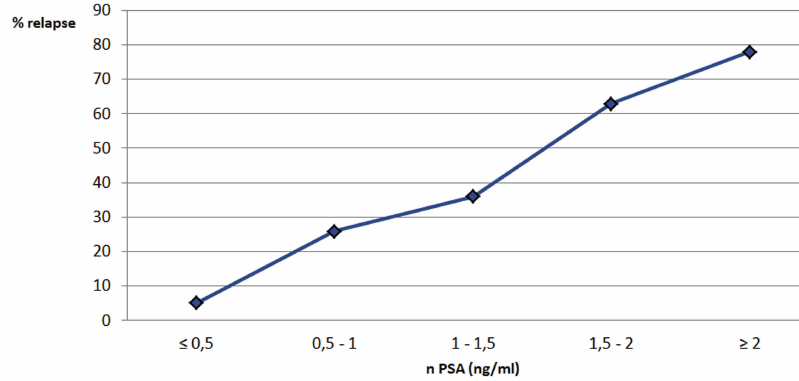
Figure 1 - % relapse compared to nPSA level. Patients attaining a low PSA nadir have a significantly improved BFFF. When we compare the 5 year biochemical free survival in patients based on the PSA nadir, there is an almost linear correlation between the nadir and the relapse rate.